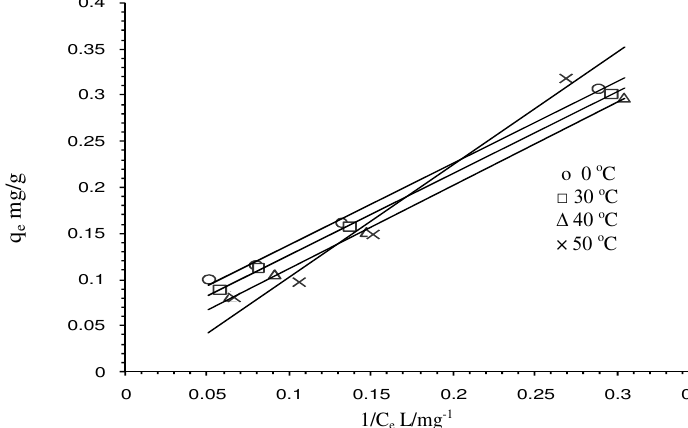
Figure 5 . Langmuir isotherm for the adsorption of Cr(VI) onto MPGP at different temperatures (PH 2, contact time = 80 min., MPGP dose = 2